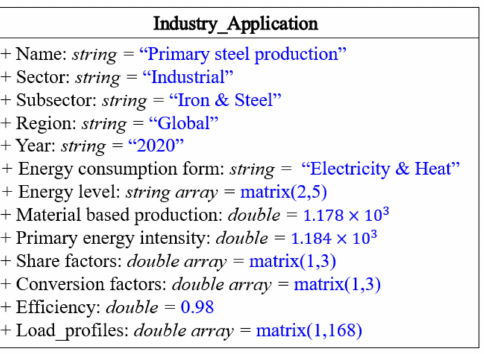
Figure 6. An example of a Household type object, showing the assigned attributes.